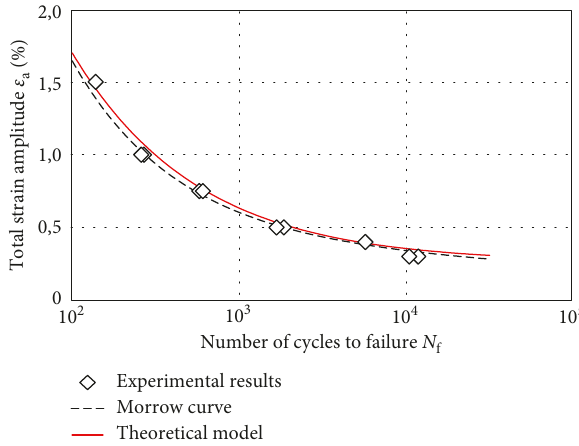
Figure 3: Comparison of the developed theoretical model with experimental